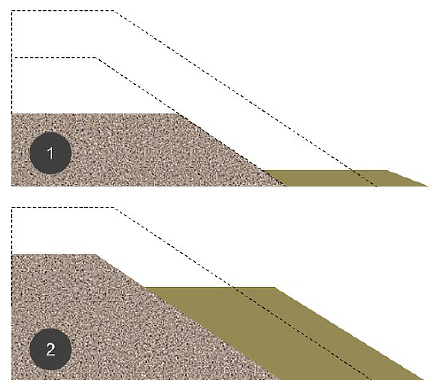
Fig. 7. Steep sand core with horizontal installation of cover layer in layers of 20–50 cm beside the sand core. Step 1: sand core 1 m, 3 layers of cover material. Step 2: sand core full size, finishing of cover in layers of 30